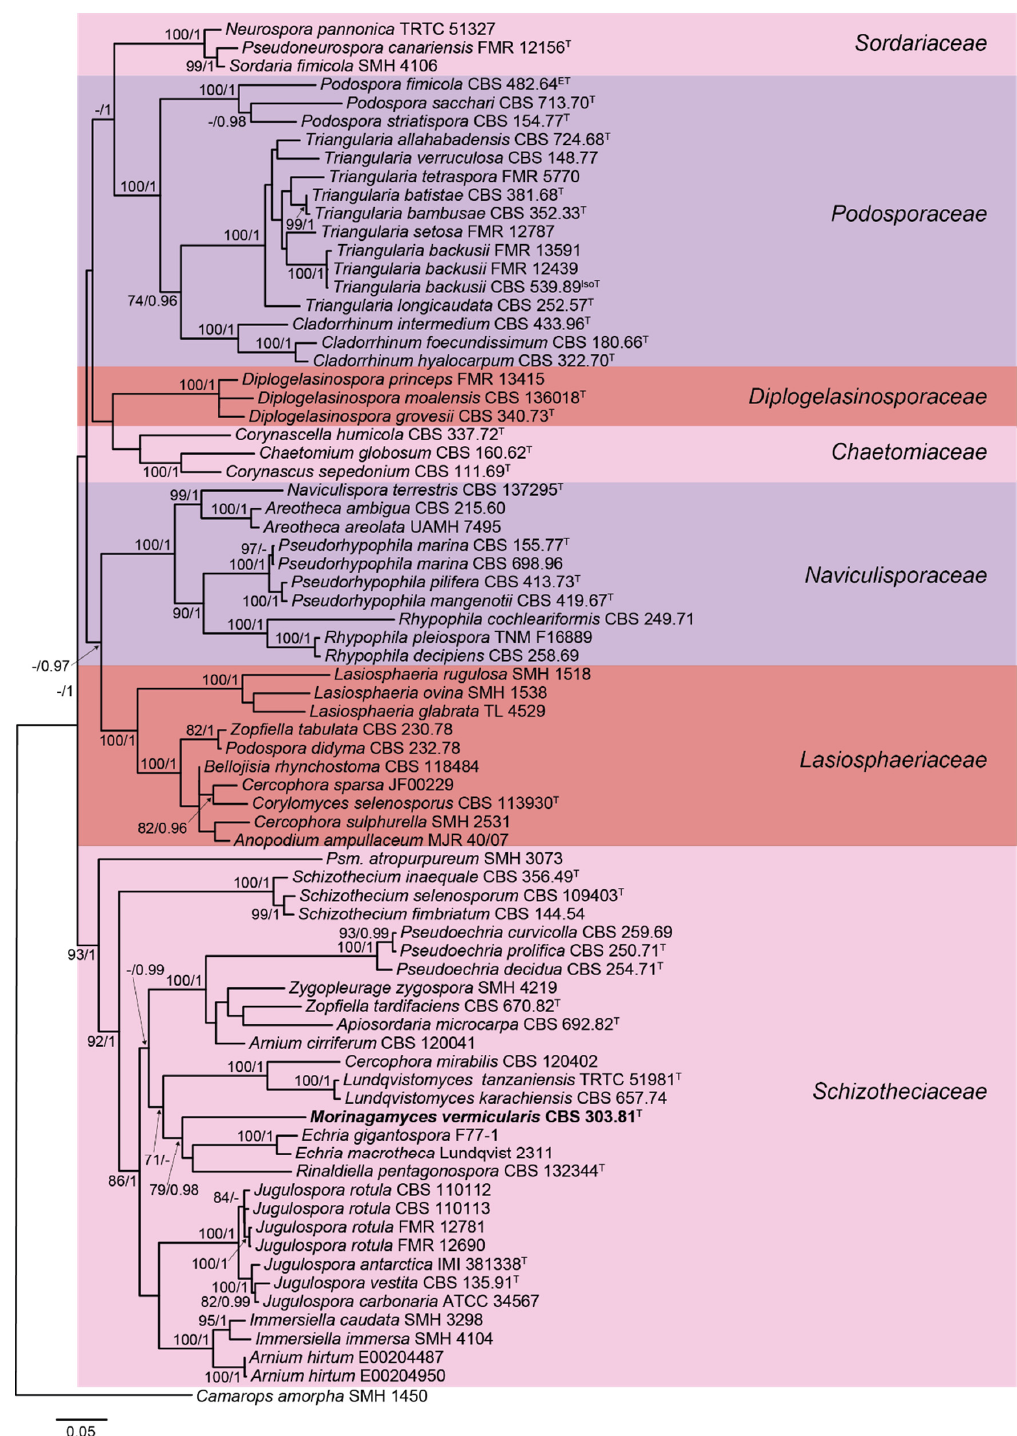
Figure 1. RAxML phylogram obtained from the combined sequences of the internal transcribed spacer region (ITS), the nuclear rDNA large subunit (LSU), and fragments of ribosomal polymerase II subunit 2 ( rpb2 ) and β -tubulin ( tub2 ) genes of selected strains belonging to the families Chaetomiaceae, Diplogelasinosporaceae, Lasiosphaeriaceae, Naviculisporaceae, Podosporaceae, Schizotheciaceae, and Sordariaceae. Camarops amorpha was used as outgroup. Bootstrap support values ≥ 70/Bayesian posterior probability scores ≥ 0.95 are indicated along branches. Branch lengths are proportional to distance. Novelty is indicated in bold . Ex-epitype, ex-isotype, and ex-type strains of the different species are indicated with ET , IsoT and T , respectively.